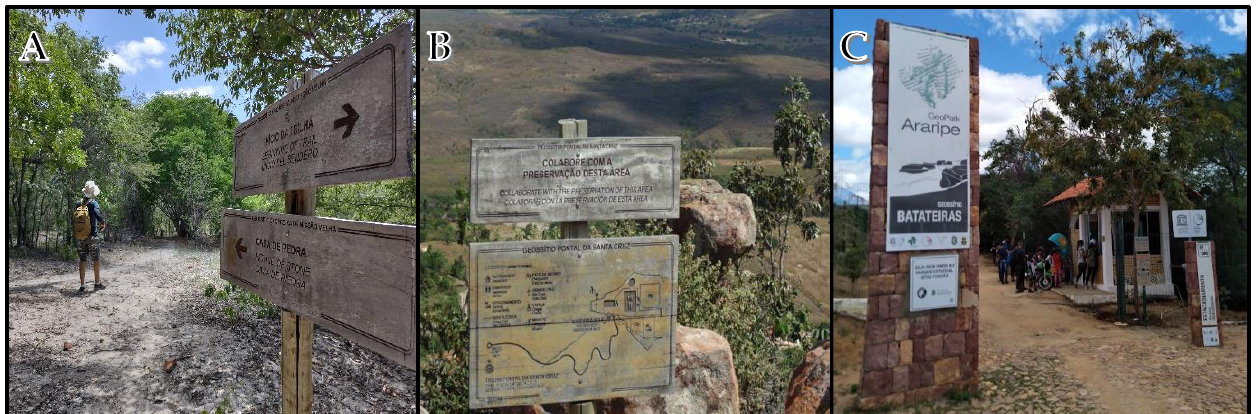
Figure 9. Course and Orientation: Signs along the trails (example). ( A ) — Missão Velha Waterfall trail; ( B ) — Pontal da Santa Cruz trail; ( C ) — Sítio Fundão trail (Batateiras Geosite); Araripe UGG. Source: Research Collection.